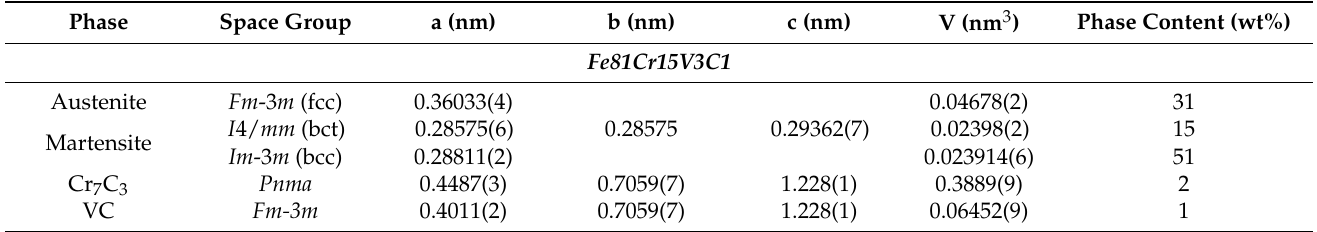
Figure 4. XRD patterns of the cast FeCrVC alloy after Rietveld refinement: dotted line shows the measured values and the solid line shows the calculated values, identifying the phases bcc-martensite (1a), bct-martensite (1b), fcc-austenite (2), Cr 7 C 3 (3) and VC (4). Table 2. Please change to: Lattice parameters and phase contents of identified phases in Fe81Cr15V3C1 determined by Rietveld refinement of XRD